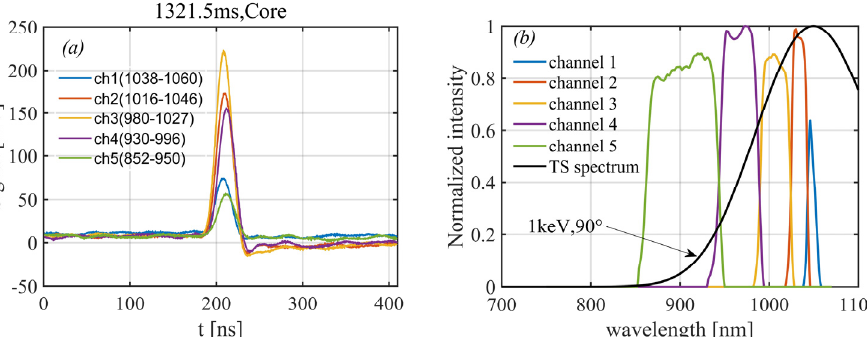
Figure 6. ( a ) The waveforms of the final signals of five channels for the core point. ( b ) The relative response versus wavelength of the five channels of the corresponding polychromator for the core point; and the normalized theoretical TS spectrum of 1 keV at a scatter angle of 90°.